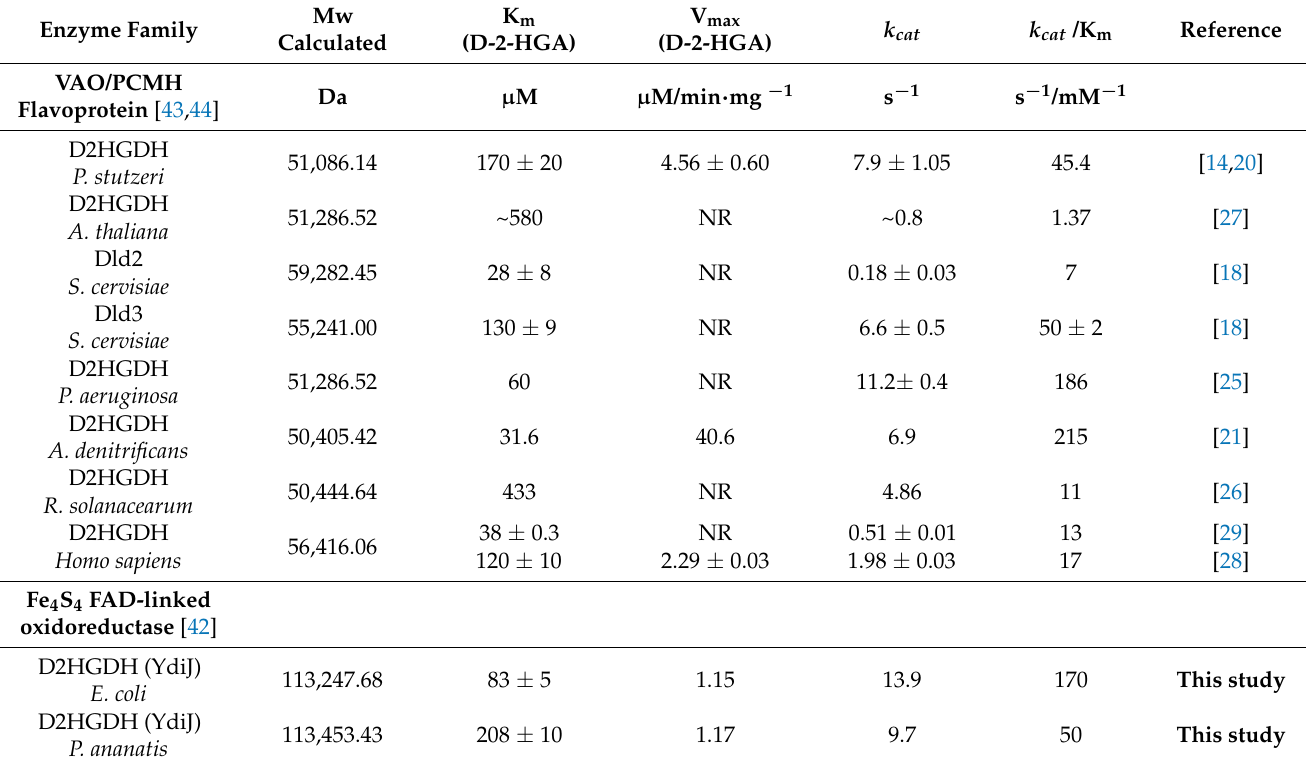
Table 2. Steady-state kinetic parameters of known D2HGDHs toward